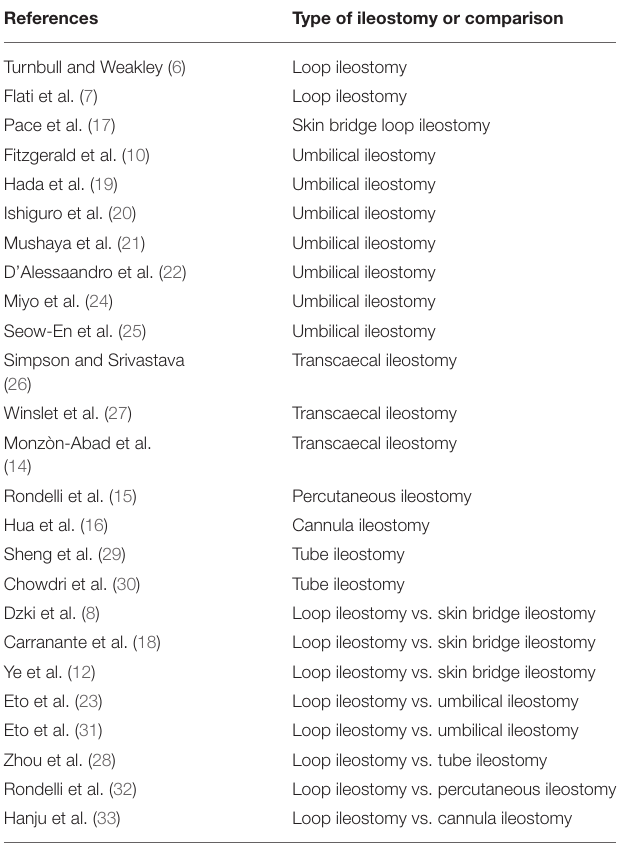
TABLE 1 | Characteristics of the main included